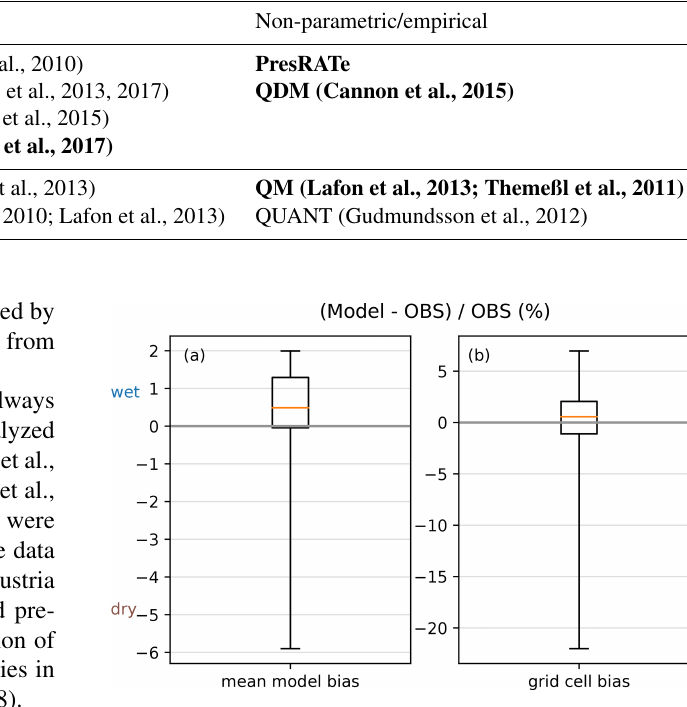
Figure 2. Box and whisker plot for the relative annual precipitation bias (%) of the ÖKS15 and STARC-Impact models (a total of 35 models) to the observational data set GPARD1 for the reference pe- riod 1971–2000. A positive bias indicates that the model is wetter than the observations. (a) Relative bias for the area mean for each climate models in Austria. (b) Relative bias on a grid cell basis. The upper (lower) whisker shows the 99.9 (0.1) percentile. The box ranges from the 25th to the 75th percentile, the horizontal orange line shows the